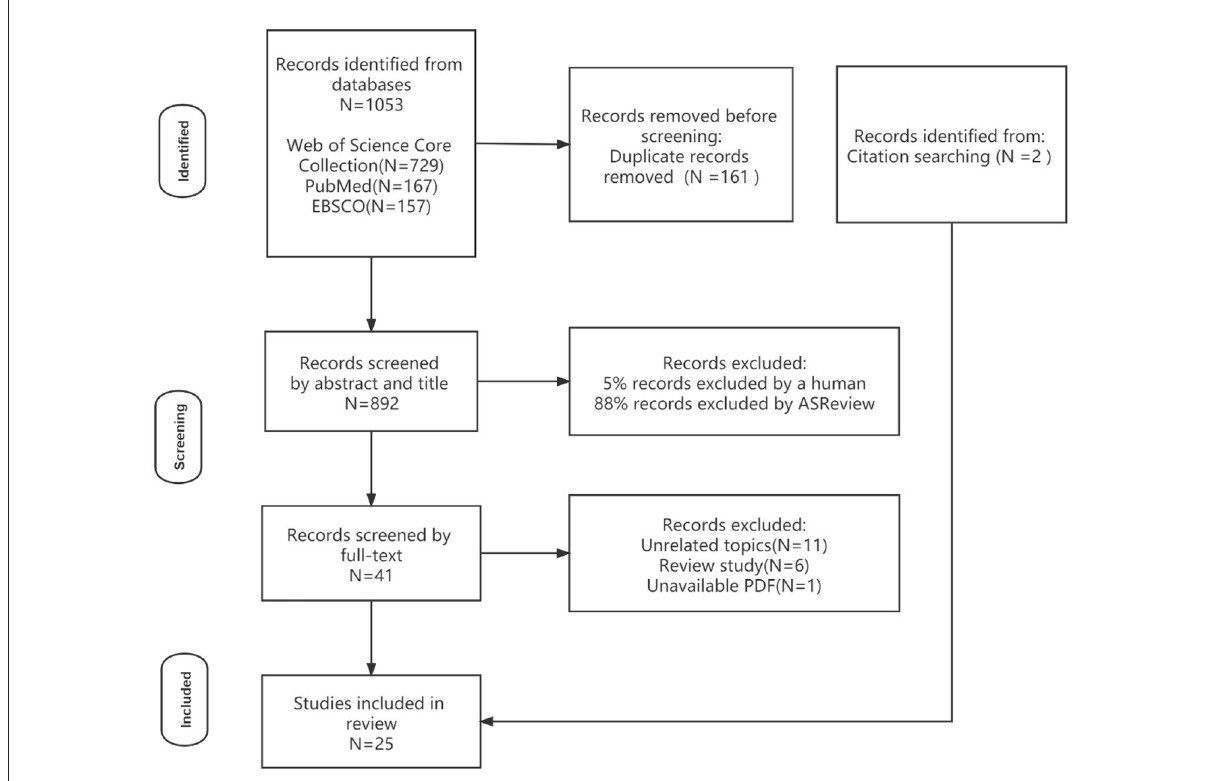
FIGURE1 PRISMA flow chart for